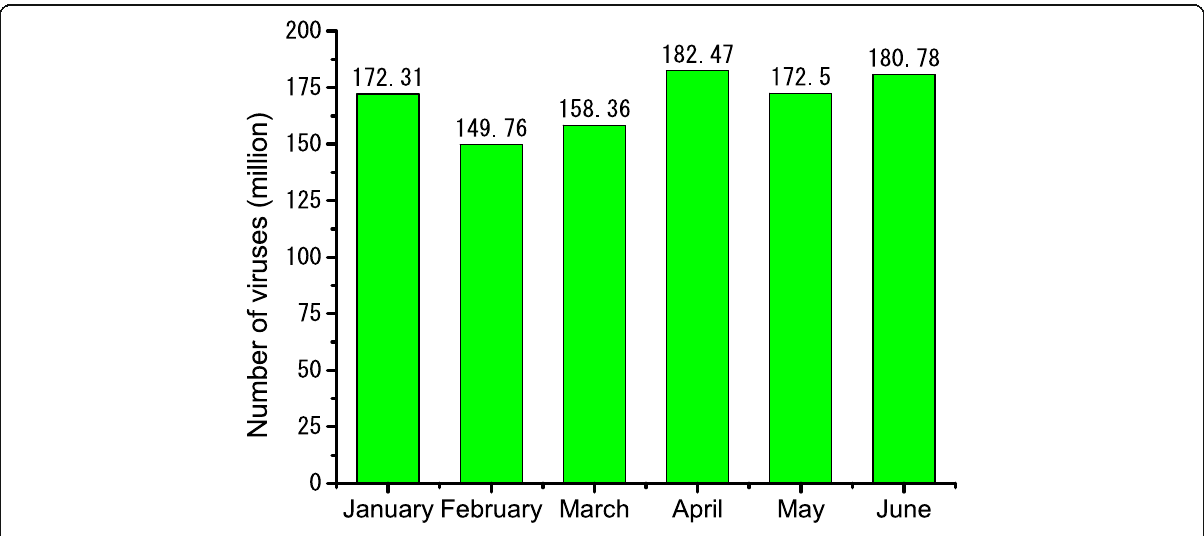
Fig. 1 Number of viruses intercepted by the